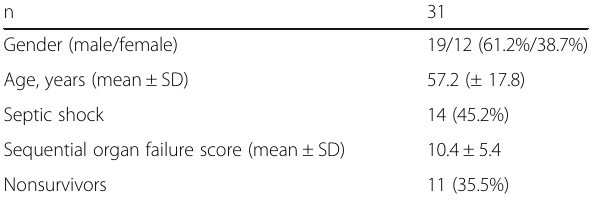
Additional file 5: Figure S4.